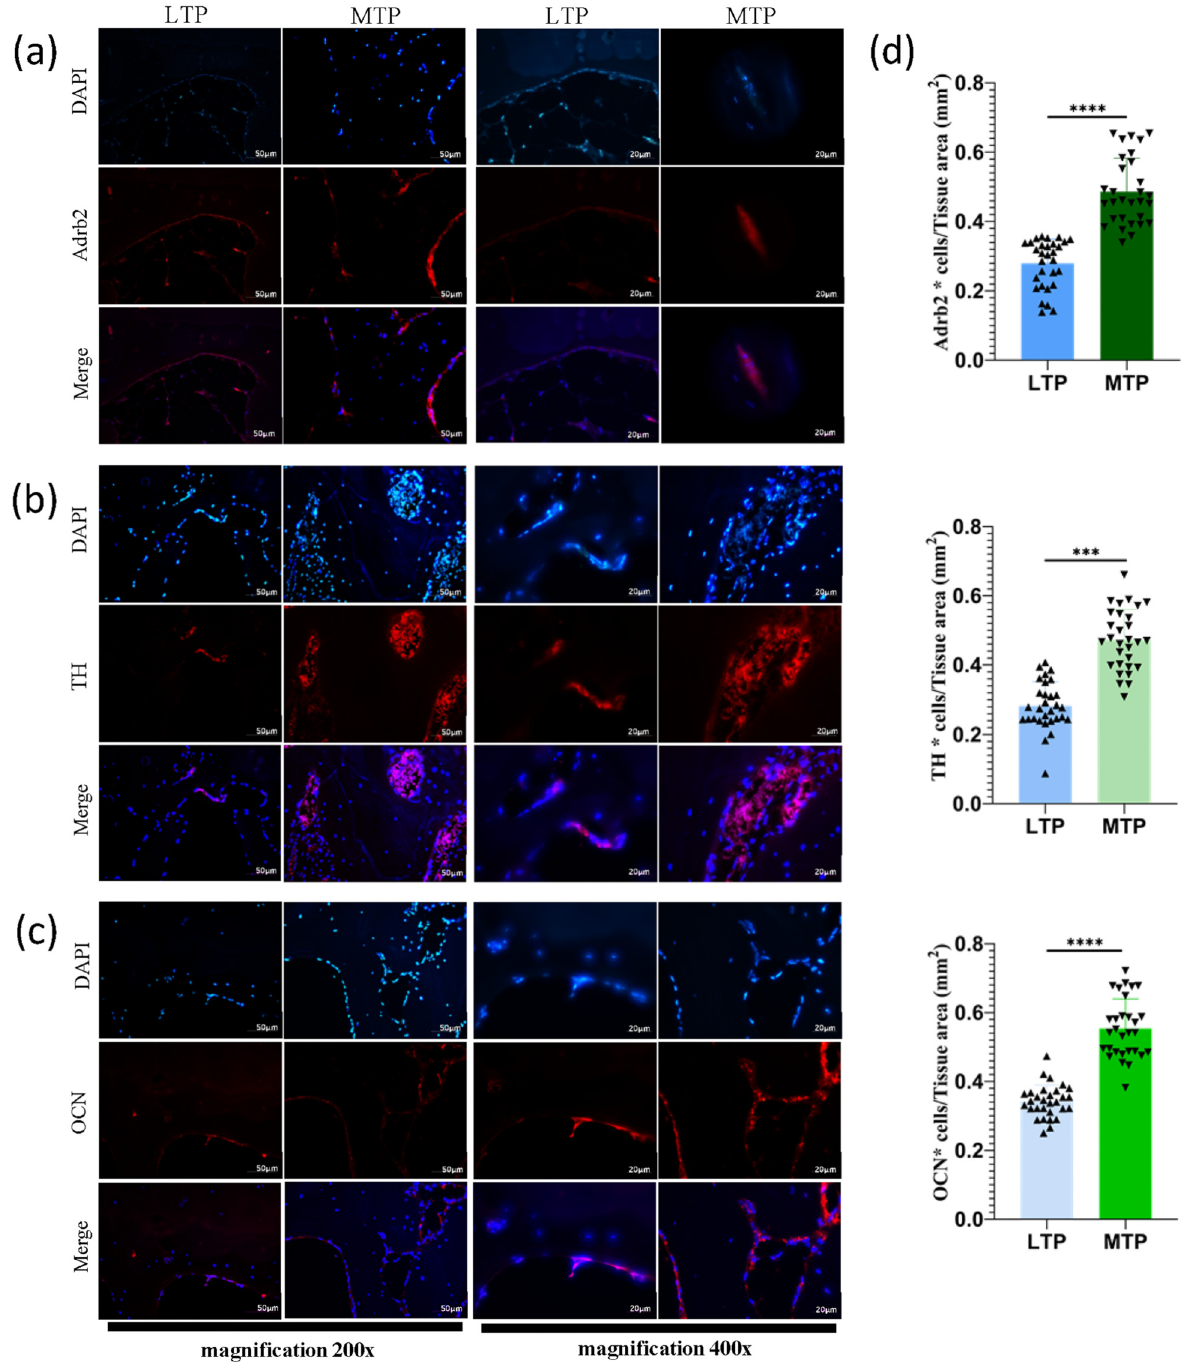
Figure 5: Immuno fl uorescence analysis of Adrb2, TH, and OCN expression in subchondral bone of LTP and MTP. ( a ) In the subchondral bone of MTP, Adrb2 ( red ) is mainly expressed on the cell membrane of multinucleated cells. In the subchondral bone of LTP, Adrb2 was mainly expressed on the membrane of multinucleated cells at the edge of the subchondral bone. ( b ) TH ( red ) is mainly distributed in the edge of the subchondral bone and the bone marrow cavity. ( c ) OCN ( red ) is distributed on the edge of the subchondral bone and is mainly expressed in the cell membrane and intercellular space of osteoblasts, presenting granular distribution. Nuclei were stained with DAPI ( blue ) . ( d ) Bar graphs show semiquantitative evaluation of Adrb2, TH, and OCN immuno fl uorescence. Magni fi cation × 200, scale bar 50 µm; magni fi cation × 400, scale bar 20 µm; *** P < 0.001, **** P <